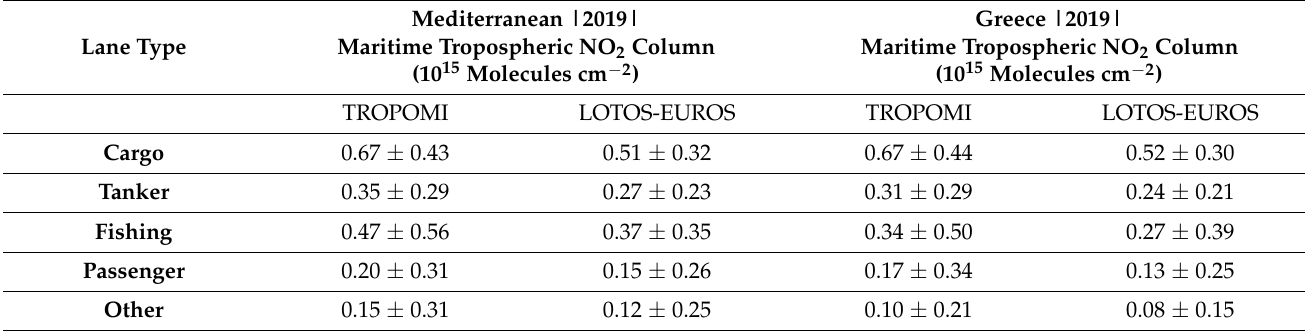
Table 2. Mean and standard deviation of the mean 2019 maritime TROPOMI & LOTOS-EUROS tropospheric NO 2 columns in 10 15 molecules cm − 2 for the Mediterranean and the Greek domains, per lane